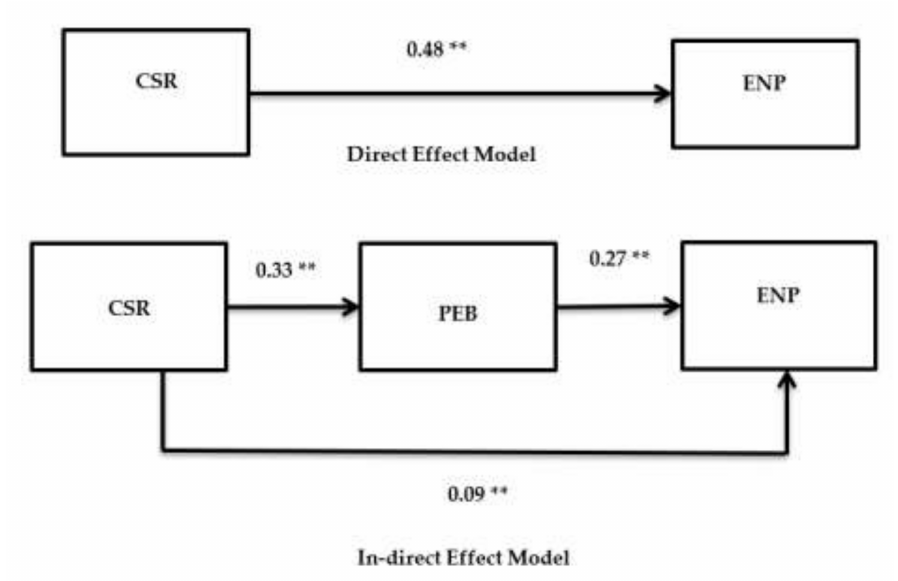
Figure 1. Direct effect model in upper pan, In-direct effect model in the lower pan. Note: ** = significant beta values ( p <